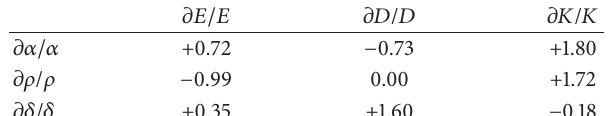
Table 2: The relative variations ( 𝜕𝐸 / 𝐸 )/( 𝜕𝛼 / 𝛼 ), ( 𝜕𝐸 / 𝐸 )/( 𝜕𝜌 / 𝜌 ), ( 𝜕𝐸 / 𝐸